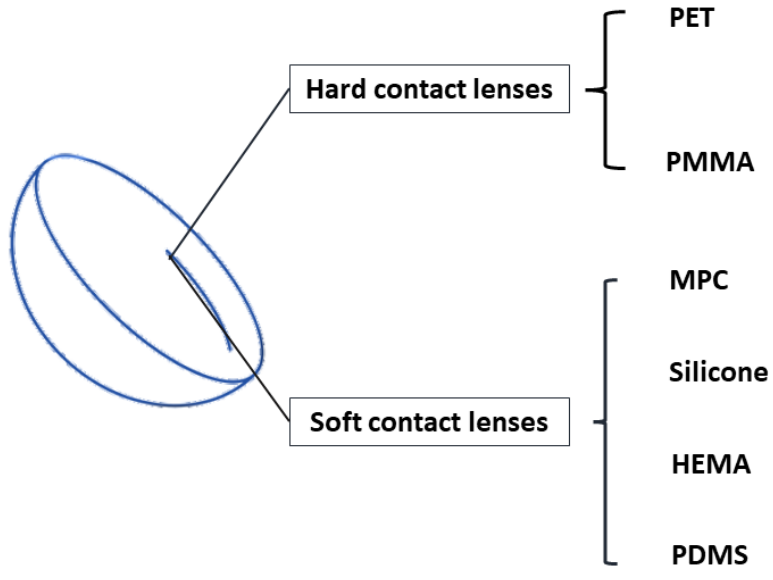
Figure 1. Hydrogel types for CLs. Table 1. Molecular formula and properties of commonly used hydrogels for